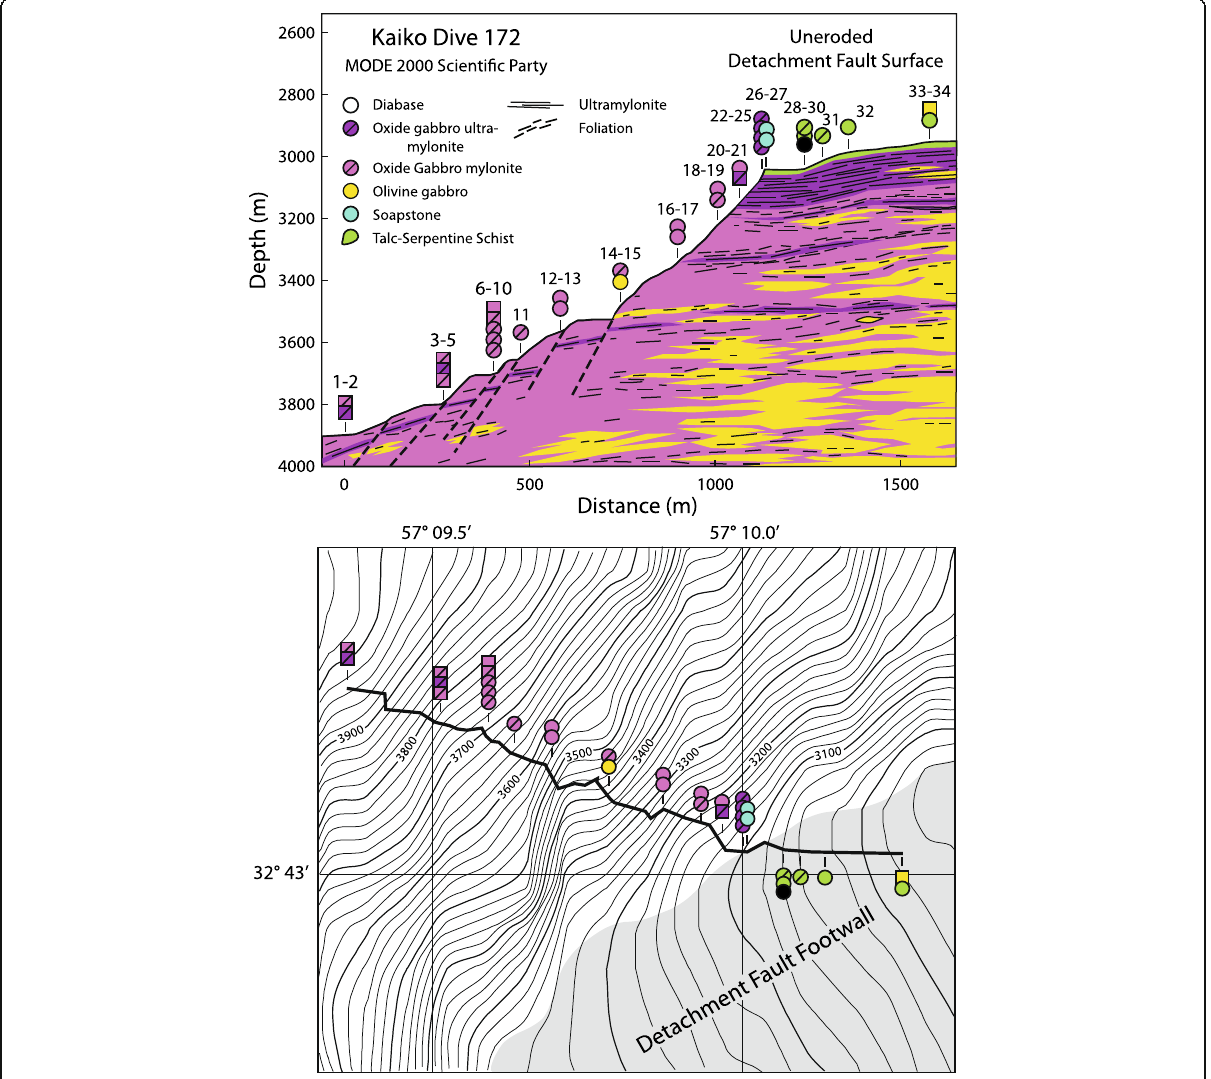
Fig. 35 Interpretative cross-section of Kaiko Dive 172 (Fig. 3) on the western transform wall. Data from Arai et al. (2001). Cross bars on oxide gabbros indicate crystal-plastic deformation grades from 2.5 to 5 (porphyroclastic). An X indicates a cataclasite. Dashed lines are inferred high- angle faults or imbricate slump structures. Foliations are represented as dominantly sub-parallel, because they likely strike east-west, although based on drilling they have highly variable dips and often cross cut each other, dipping both north and south. Direct observation, however, indicates that the ultramylonite is conformable to the detachment fault